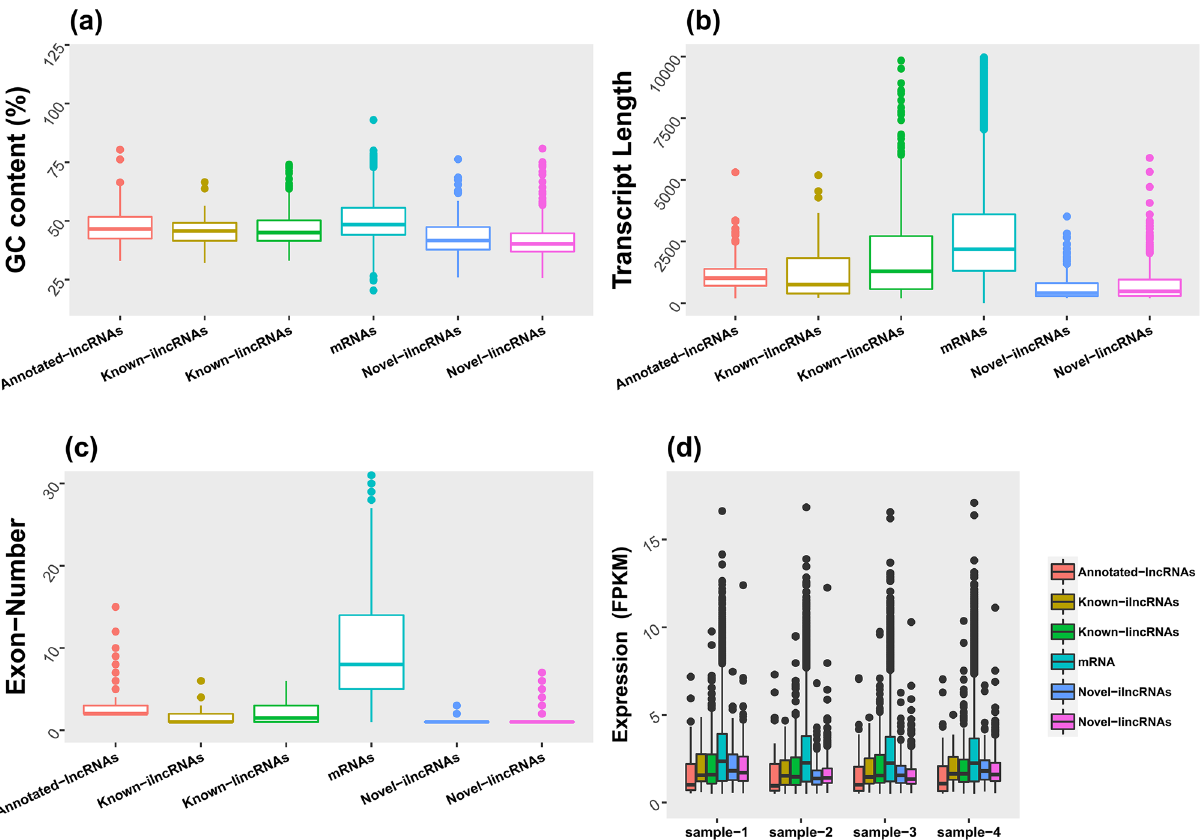
Figure 2. Comparison of ( a ) GC contents, ( b ) transcript length, ( c ) exon number and ( d ) gene expression levels of the annotated, novel and known lncRNAs with